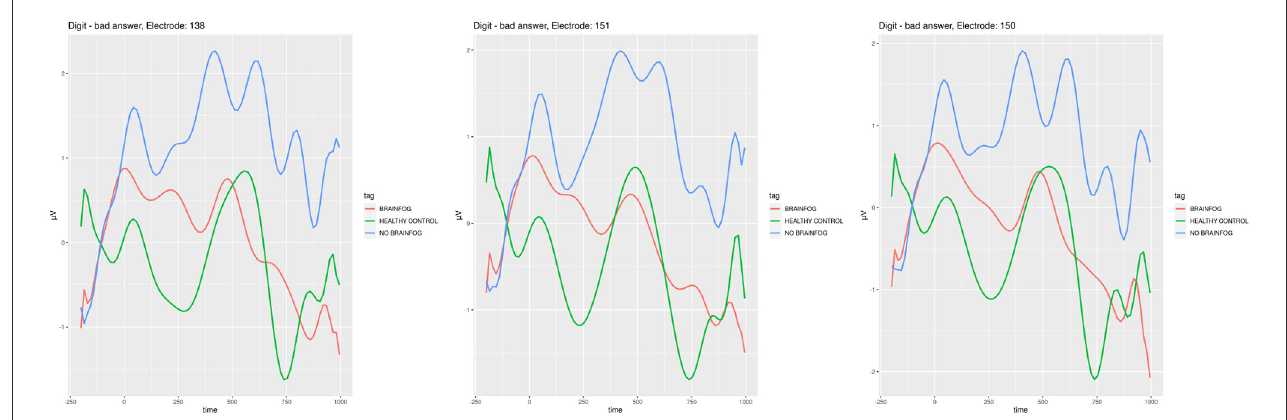
FIGURE6 ERP plots generated for the electrodes E138 , E151 , and E150 that showed the smallest cross-correlation in the digit span experiment when the participants were wrong . Red line—the participants that suffered from COVID-19 and with brain fog symptoms. Blue line—the participants that suffered from COVID-19 and without brain fog symptoms. Green line—the participants without COVID-19 episode. See also Tables 6–10 in Appendix A.